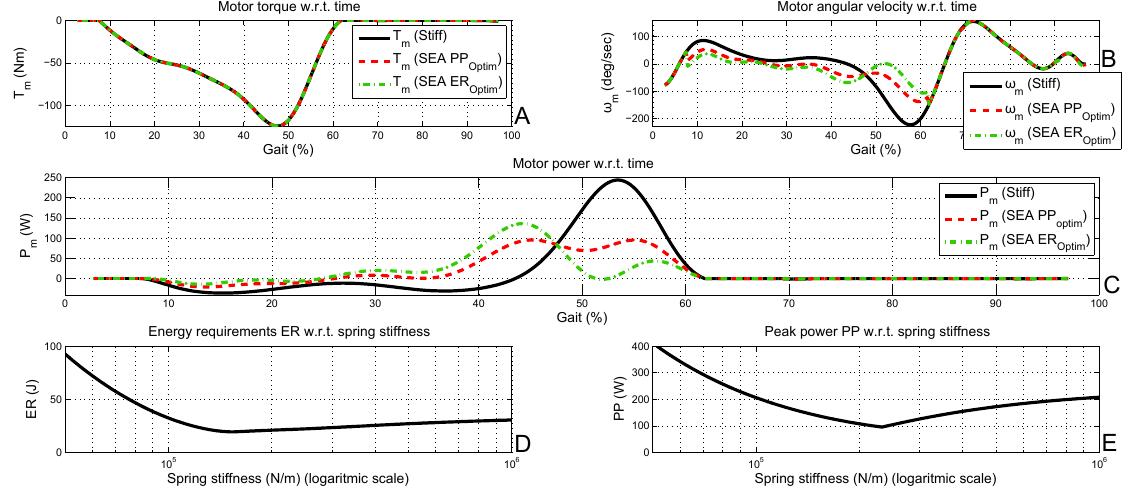
Figure 3. The motor requirements for both stiffnesses are plotted in (A,B,C). As indicated by (D,E), the optimization for energy requirements (ER) and peak power (PP) results in a different